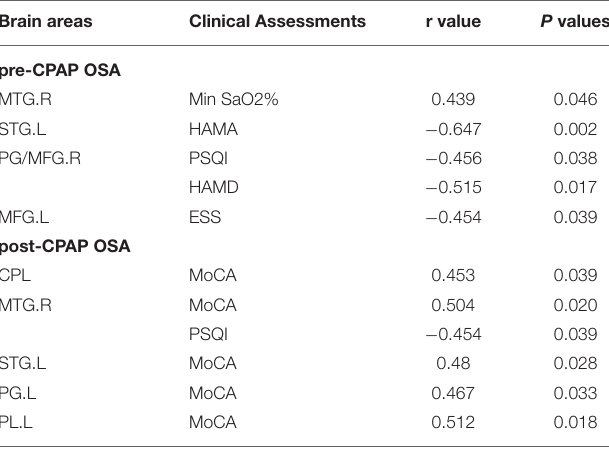
TABLE 4 | Correlation analyses between altered DC and clinical assessments in pre-and post-CPAP OSA patients. Brain